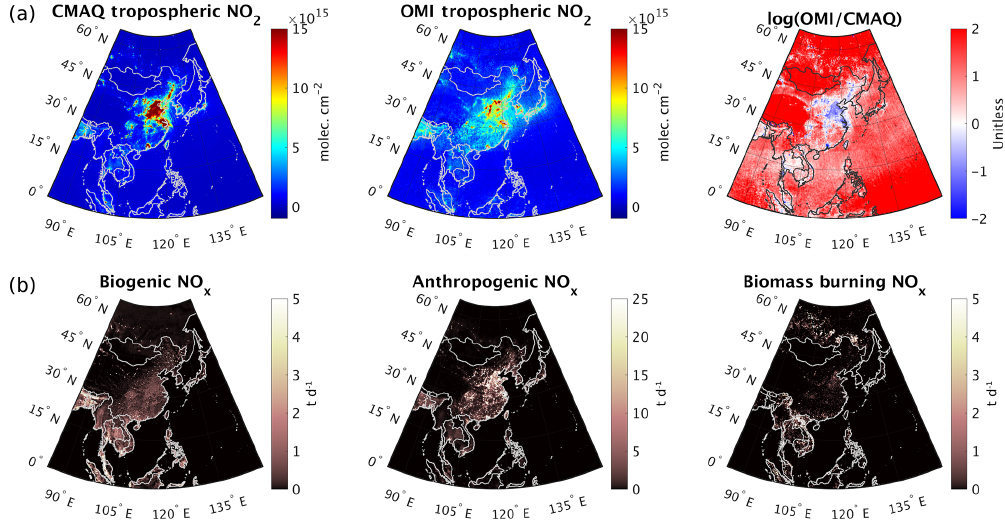
Figure 2. (a) Tropospheric NO 2 columns from the WRF-CMAQ model, OMI (using adjusted AMFs based on the shape factors derived from the model and bias-corrected following Choi et al., 2020), and the natural logarithmic ratio of OMI / CMAQ during May–June 2016 at ∼ 13:30LST. (b) The major sources of NO x emissions in the region including biogenic (soil) emissions simulated by MEGAN, anthropogenic emissions estimated by MIX-Asia (2010), and biomass burning emissions made by FINN. The emissions are the daily mean values based on the emissions in May–June.